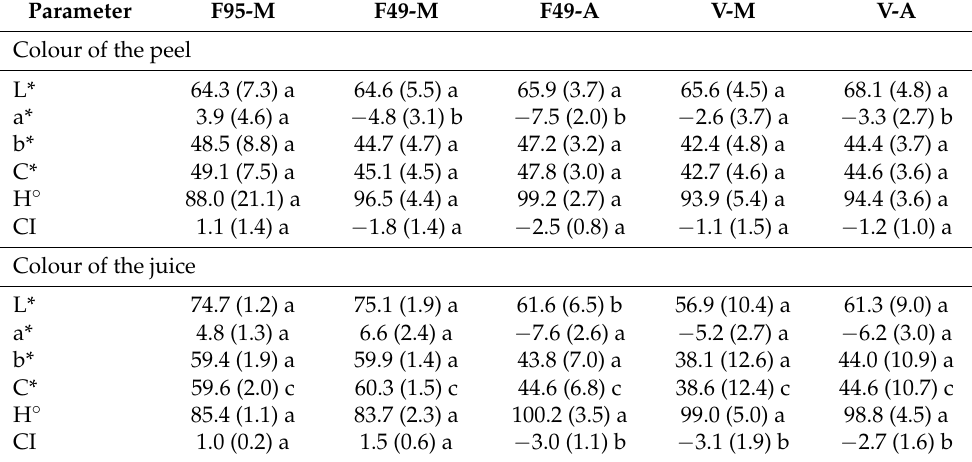
Table 3. Variations in the colour of the skin and the juice of lemons (“Fino 95”, “Fino 49” and “Verna”) obtained in different rootstocks ( C. macrophylla and C. aurantium ), where L* represents the luminosity, a* the green/red, b* blue/yellow, C* the chroma values, H ◦ the hue angle and CI (color index) the citrus colour index. The values represented are the mean with their standard deviation in parentheses.